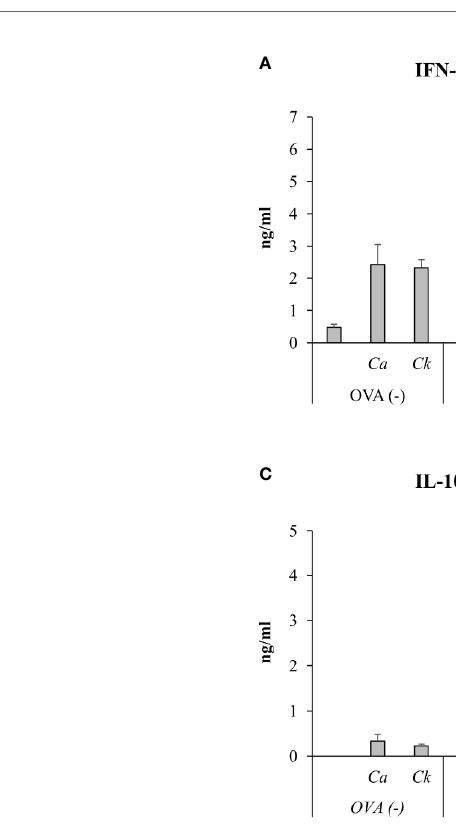
FIGURE 7 | In vivo immunization of C. albicans or C. krusei b -glucans. Mice were subcutaneously immunized with a mixture of C. albicans or C. krusei b -glucans and OVA at day 0 and day 7. On day 14, the draining LNs cells were isolated and were ex vivo re-stimulated with OVA for 48 h. Culture supernatants were measured for (A) IFN- g , (B) IL-17, and (C) IL-10 by ELISA. (D) CD4 + FoxP3 + T cells were assessed by fl ow cytometry. n = 6. * p < 0.05. Ca , C. albicans ; Ck , C. krusei